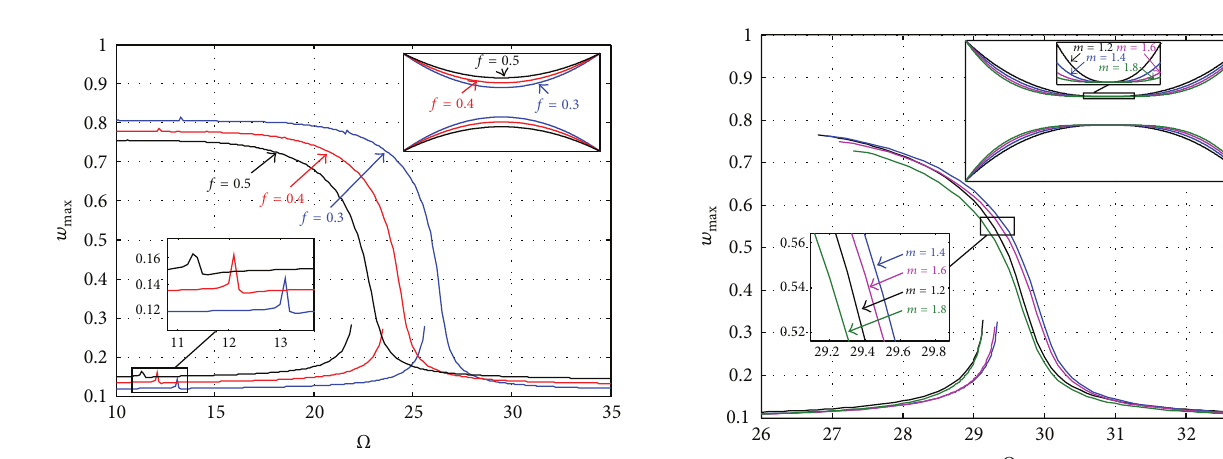
Figure 12: Comparison of dynamic response curves of different curvature 𝑚 (0.8–1.2).